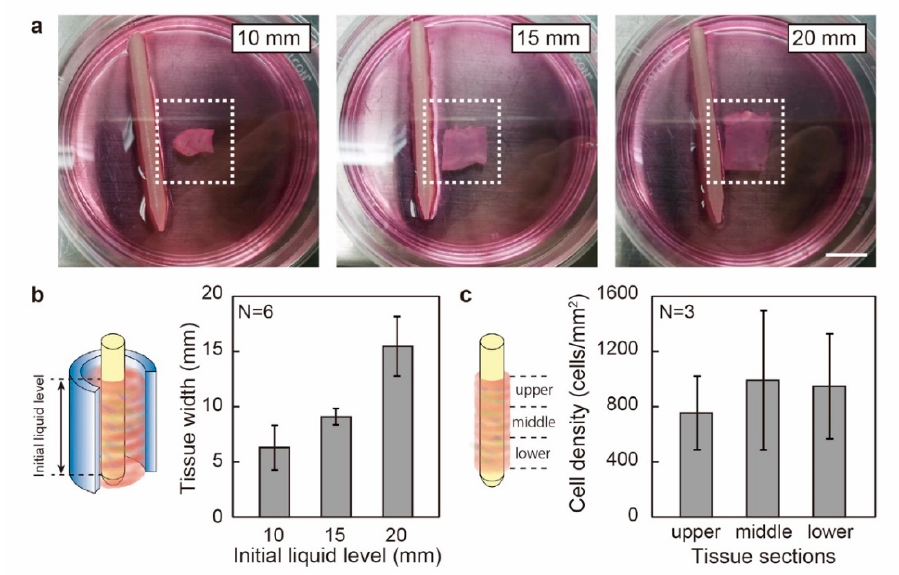
Figure 2. Shape and homogeneity of the biofabricated plane-shaped muscle tissue. ( a ) Images of the tissues fabricated with various initial liquid levels. The tissues are placed so that the length directions are roughly aligned with the horizontal directions. ( b ) The measured widths of the tissues fabricated with the various initial liquid levels. ( c ) Cell densities for the upper, middle, and lower sections of the fabricated tissue. Scale bar: 1